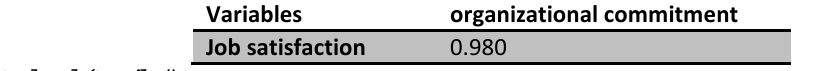
Table 6. Pearson correlation coefficient between job satisfaction in general and organizational